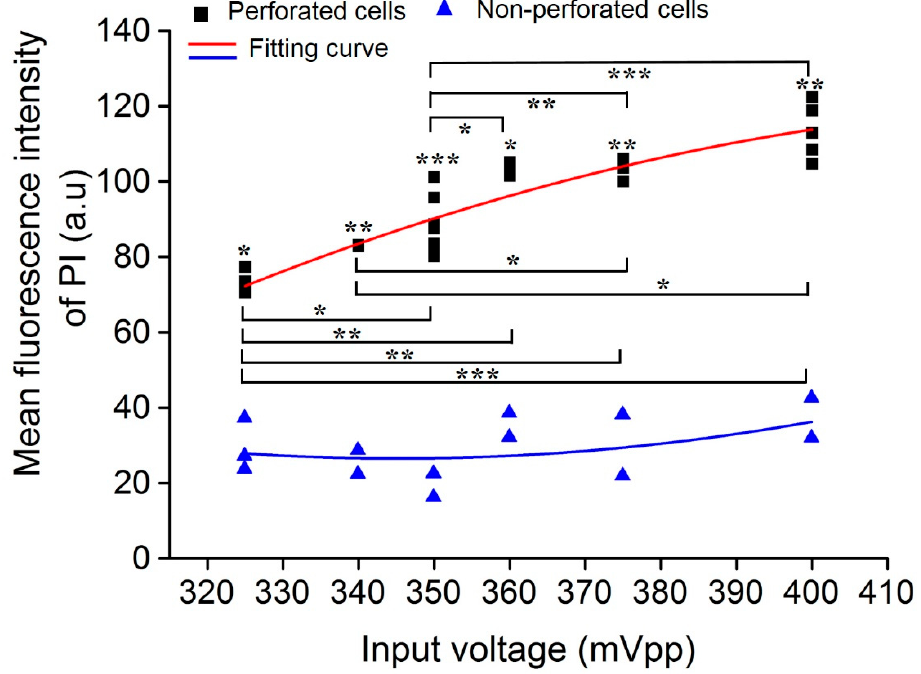
Figure 7. The impact of acoustic input voltage on cell sonoporation. The relationship between the ultrasonic input voltage and the mean PI fluorescence intensity. The degree of perforation was positively correlated with the input voltage. *** p < 0.001, ** p < 0.01, and * p < 0.05.